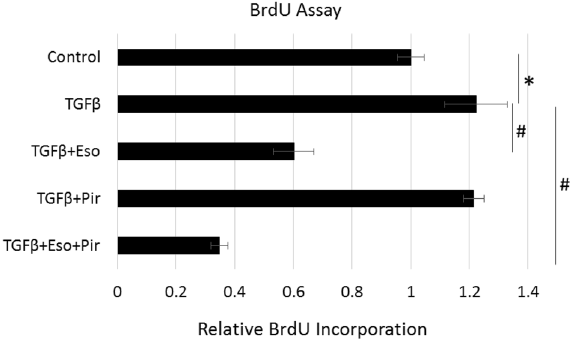
Figure 1. Bromodeoxyuridine (BrdU) assay showing anti-proliferative effects of esomeprazole, pirfenidone, and the combination of both drugs. Fibroblasts derived from the lungs of IPF patients were stimulated with TGFβ (10 ng/mL) for 24 h and treated with vehicle (dH 2 O), esomeprazole (100 µM), pirfenidone (1 mM) or esomeprazole (100 µM) and pirfenidone (1 mM) combination for another 24 h. Cell proliferation, proportional to the incorporation of BrdU, was assessed spectrophotometrically by measuring absorbance at 450 nm. Data is mean ± SEM from triplicate experiments and represents three independent experiments. *p < 0.05 compared to no TGFβ control; # p < 0.05 compared to TGFβ only